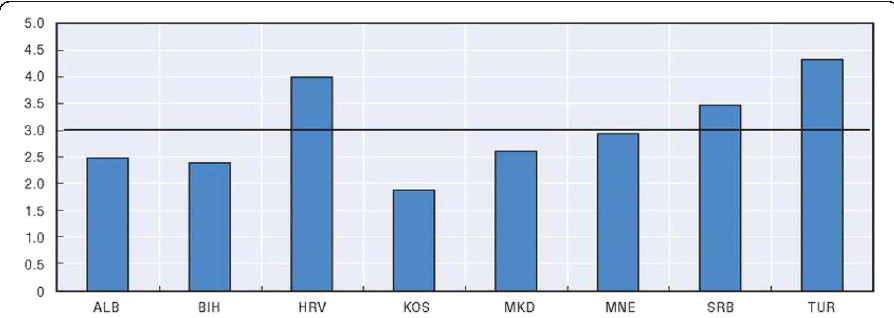
Fig. 5 Overall scores for Dimension 5a: Support services for SMEs and start-ups. Note: The line indicates the regional average of the policy dimension. Source: SBA assessment